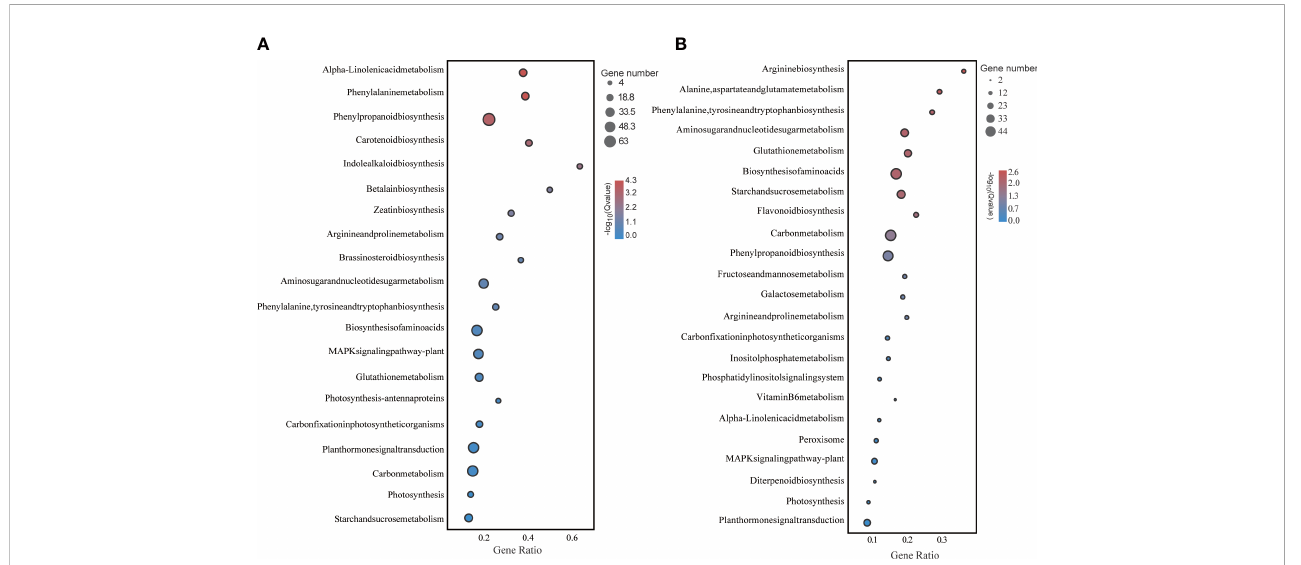
FIGURE 4 KEGG enrichment analysis of foxtail millet leaves under LD and HD treatment. (A) KEGG analysis of differentially expressed genes under LD; (B) KEGG analysis of differentially expressed genes under